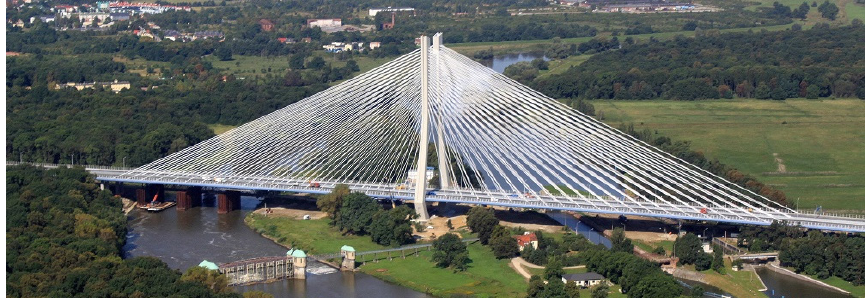
Figure 1. Aerial view of the R ę dzi ń ski Bridge (photo: W ł adys ł aw Kluczewski). The characteristic feature of the bridge is two separate box girder concrete decks.